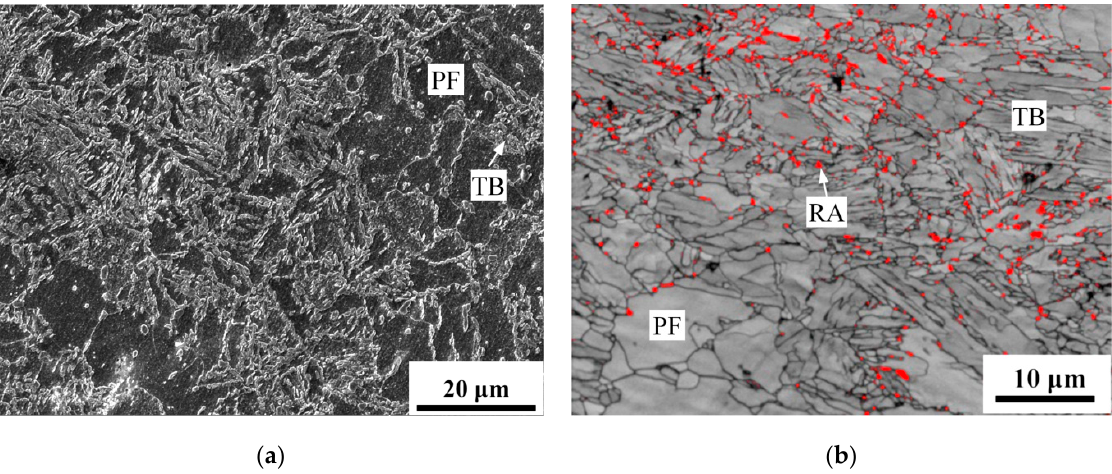
Figure 2. ( a ) SEM micrograph showing multiphase microstructure and ( b ) EBSD image showing morphology and distribution of retained austenite (RA) in the multiphase microstructure of the studied steel, in which red areas represent retained austenite. (PF: polygonal ferrite, TB: tempered bainite).